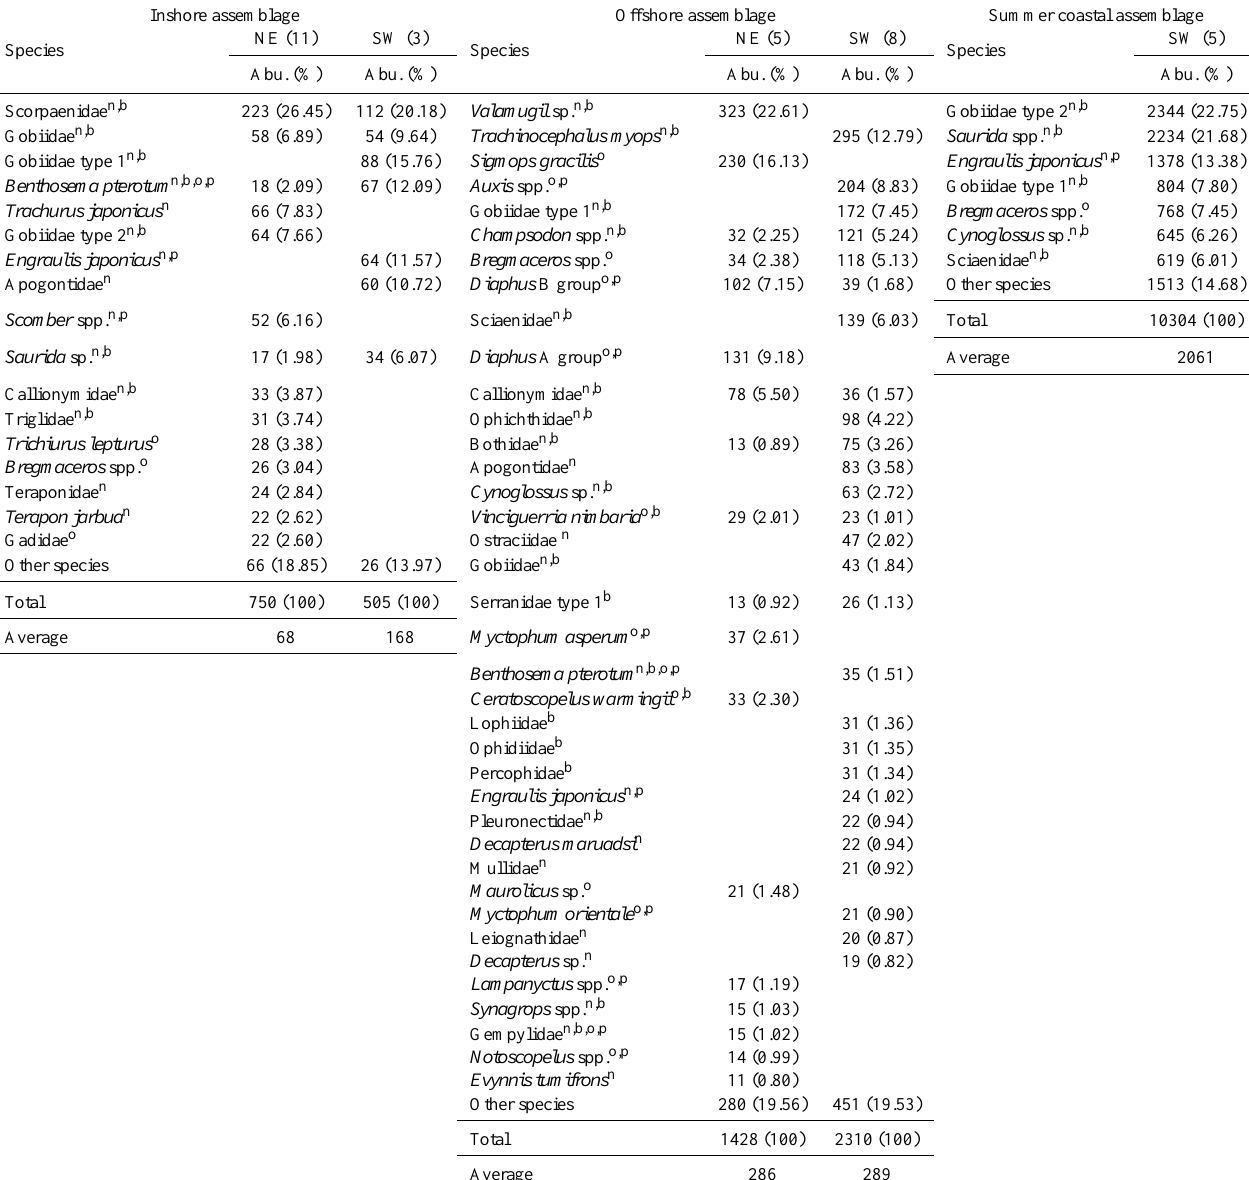
Table 3. The abundance (Abu.; i.e., CPUE, ind./1000m 3 ) and percentage contribution of dominant larval fish ( > 80%) of three larval fish assemblages in the ECS, 2008 (NE, the northeasterly monsoon season; SW, the southwesterly monsoon season). Inshore assemblage Offshore